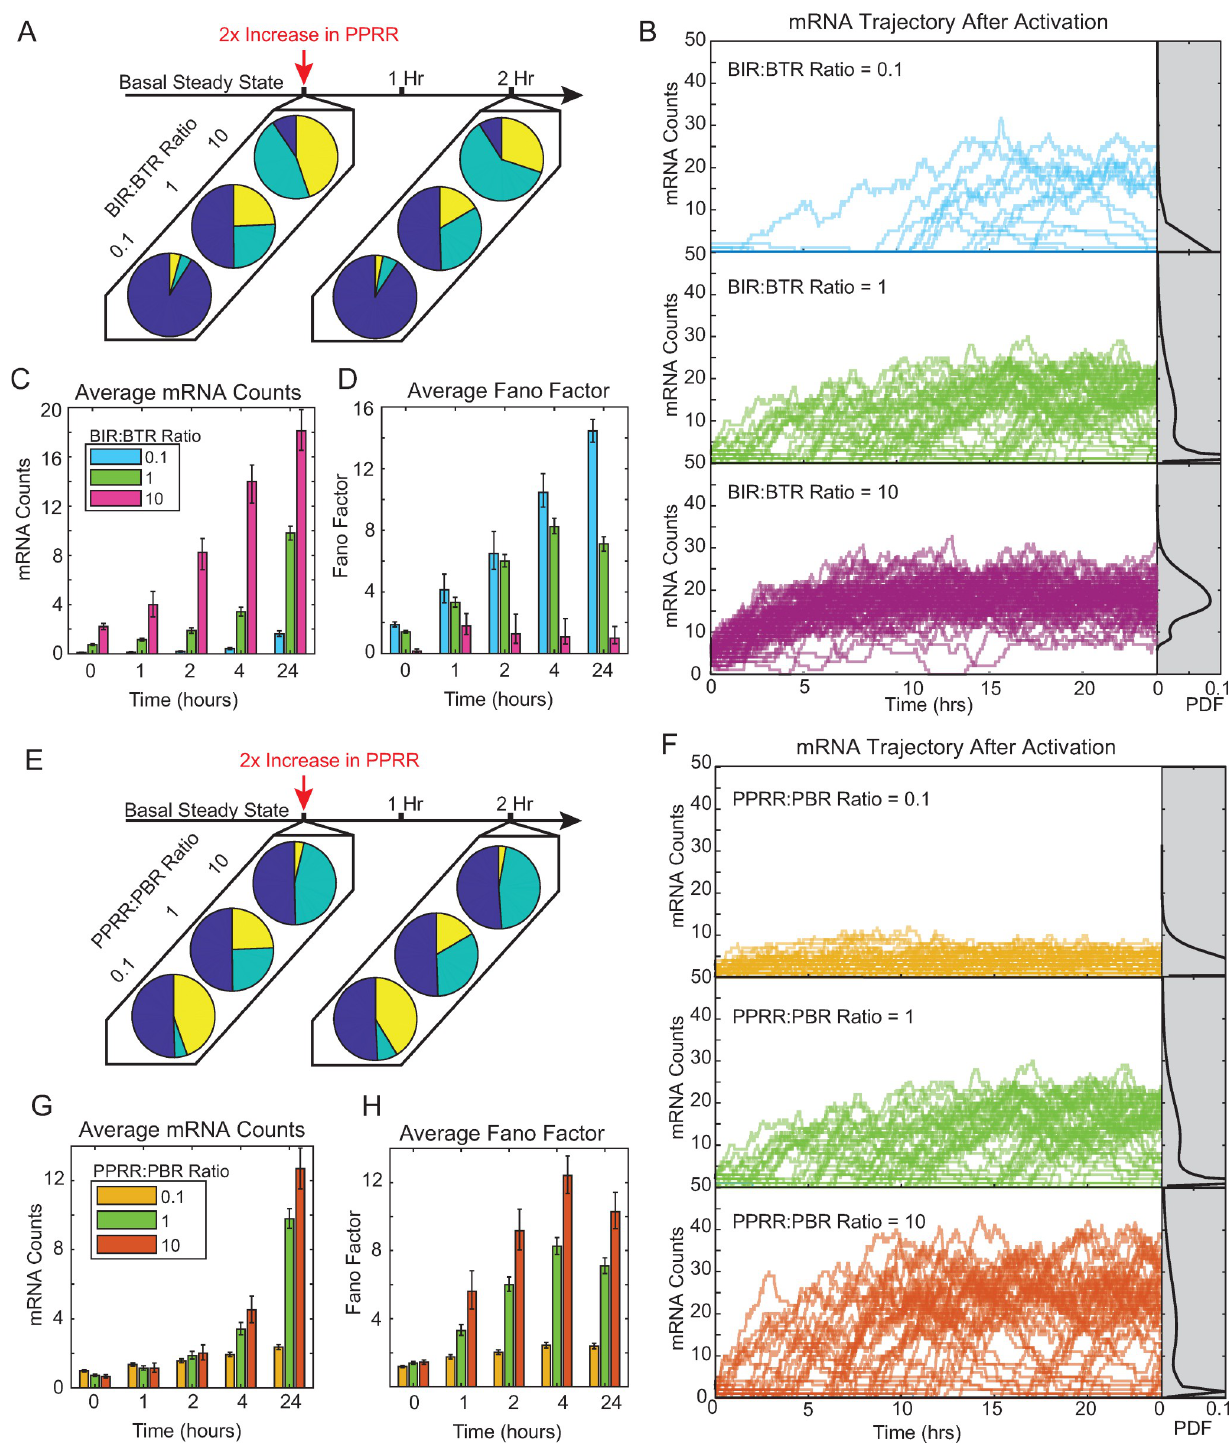
Fig 2. The initial distribution of promoter states influences the heterogeneity in transcriptional activation modeled as an increase in PPRR. (A) Three representative pie charts of fractional promoter-state probability of UP (blue), AP (teal) and BP (yellow) for BIR:BTR ratios of 0.1, 1, and 10 with PBR and PPRR held constant at 10 hr -1 . Basal conditions were calculated from 1000 single-cell stochastic simulations out to 10 days for each parameter combination. At time = 0, PPRR was increased two-fold (B), and new fractional probabilities were captured at 2 hours. (B) Representative trajectories for BIR:BTR = 10 (pink), BIR:BTR = 1 (green), and BIR:BTR = 0.1 (cerulean). Each line represents one stochastic simulation out to 24 hours. Only 100 simulations are plotted for each condition for ease of visualization. Gray regions on the right represent the probability density of mRNA counts at 24